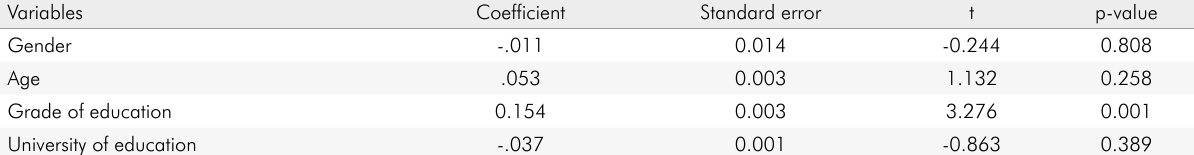
Table 4. Results of regression analysis on factors associated with COVID-19 Attitude.